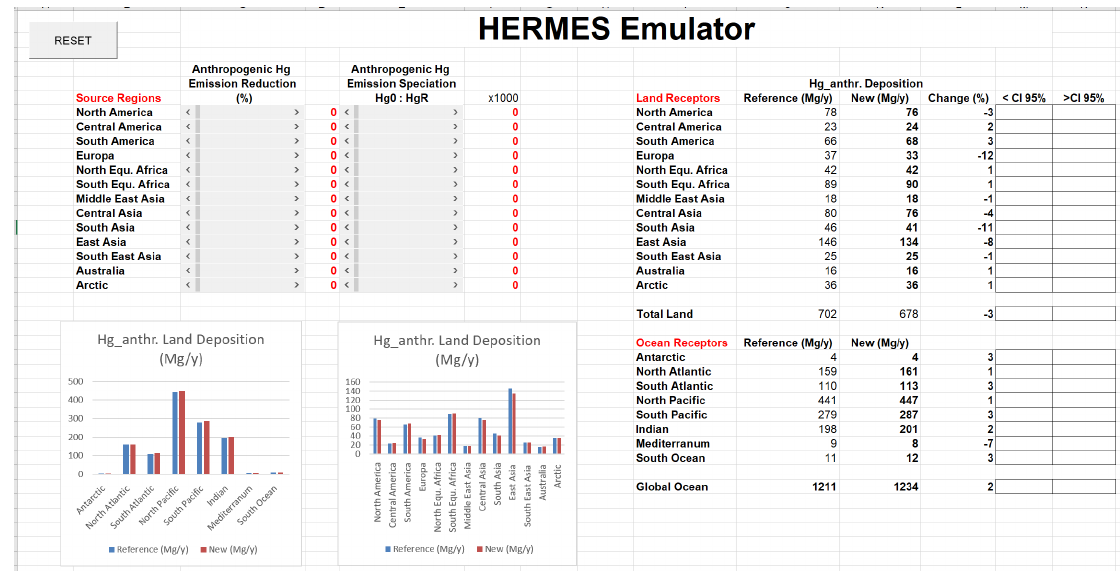
Figure 7. Use-case 5: Hg